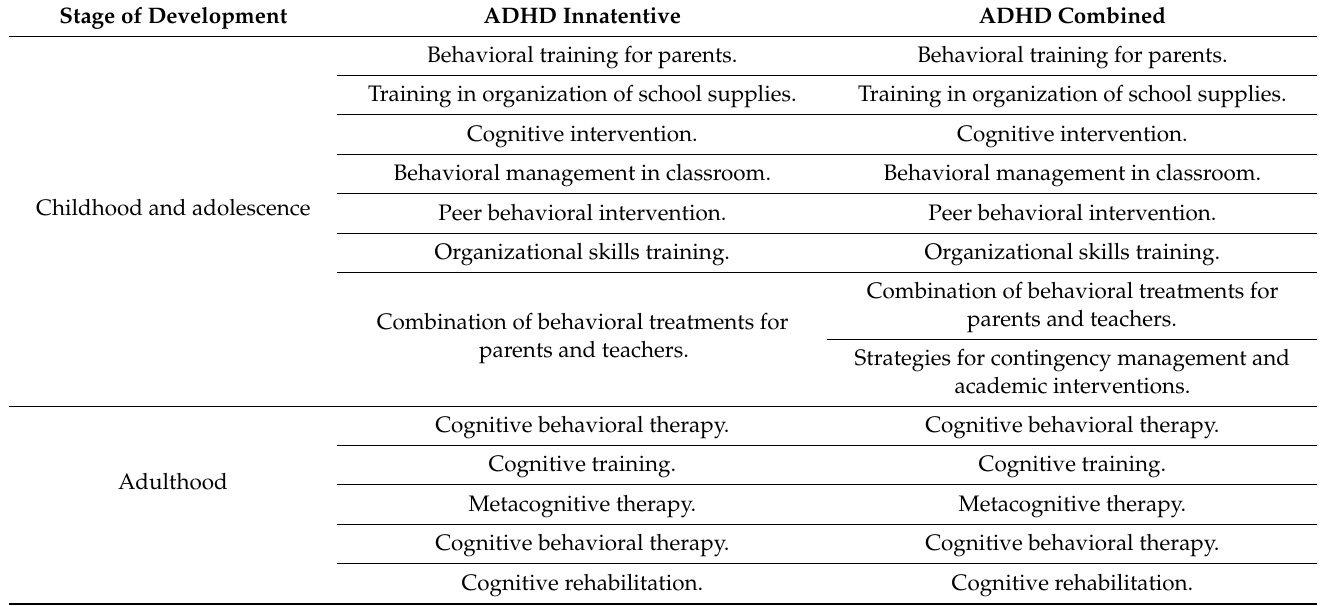
Table 6. Recommended Behavioral Therapeutic Approaches for ADHD by Developmental Stage and Clinical